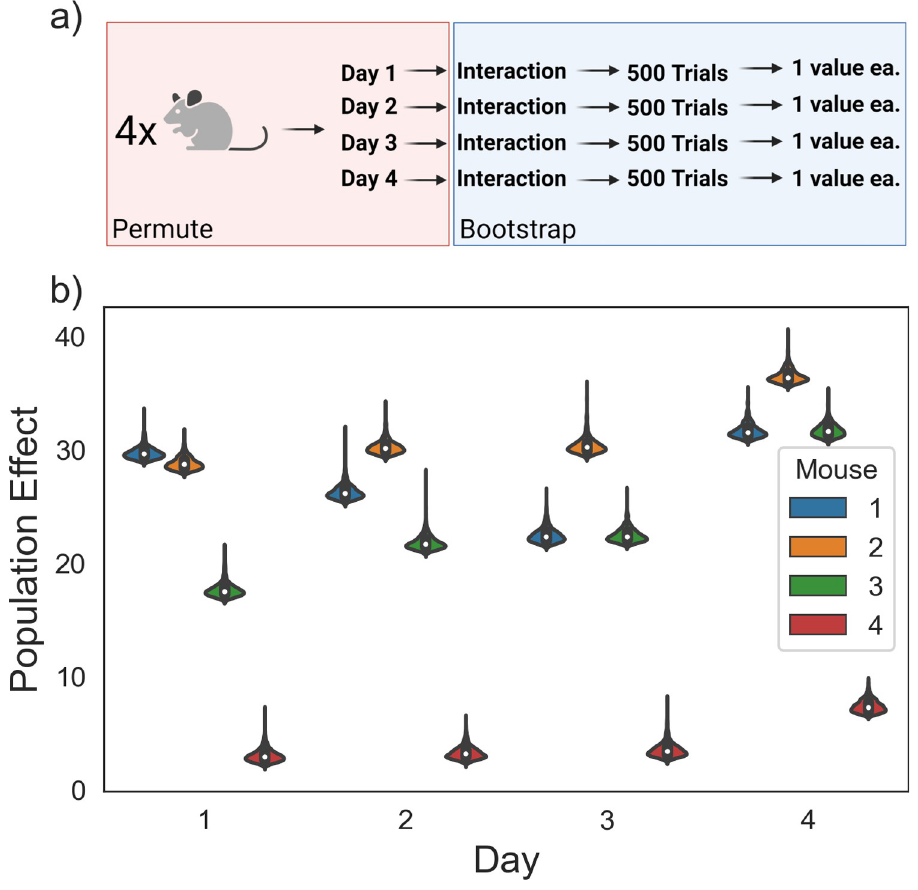
Fig 8. Analyzing an experiment with multiple treatment conditions testing a single hypothesis. (A) An experiment with four mice, two treatments each, three wells each, and three neurons each. (B) Violin plots visualizing the dataset. p = 0.024 (hierarchical randomization) for the hypothesis that there is a day-to-day increase in the population effect. Panel (A) was created using BioRender.com.